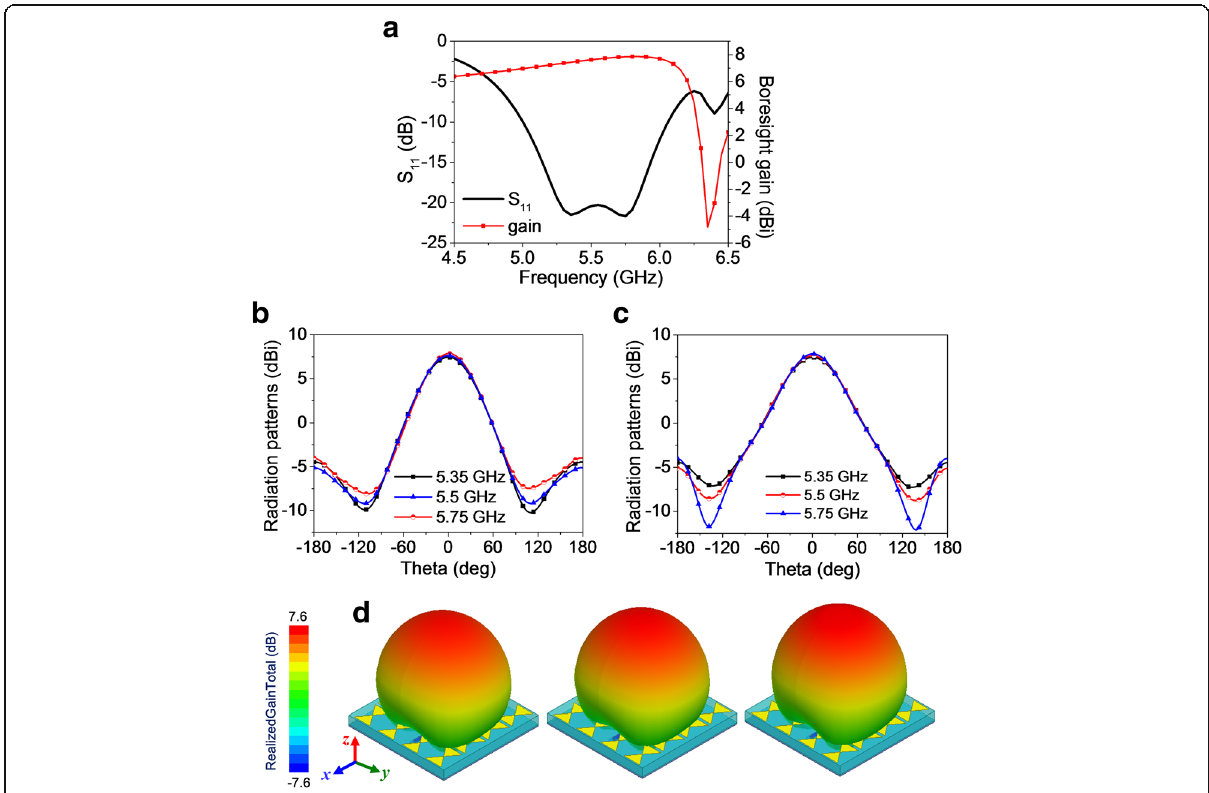
Fig. 2 Radiation properties of the anisotropic element with lumped port excitation. a Reflection coefficient S 11 and boresight gain versus frequency. 2D radiation patterns at b xoz- (E-) and c yoz- (H-) plane. d 3D radiation patterns at 5.35, 5.5, and 5.75 GHz (from left to